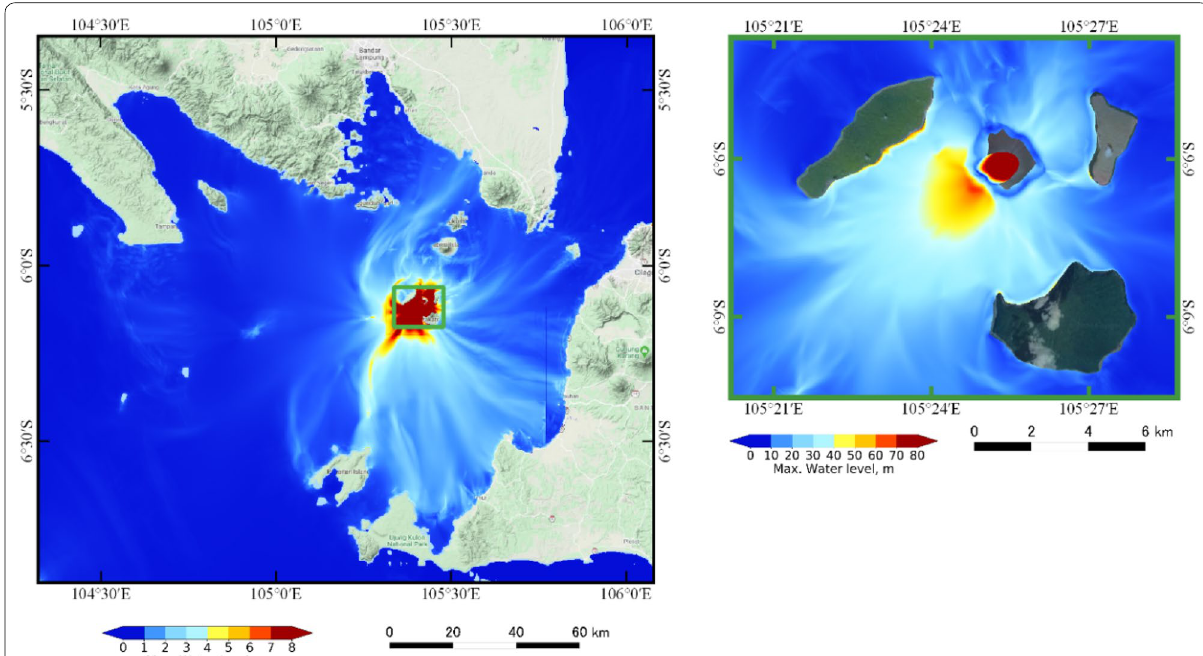
Fig. 9 Maximum wave height in the whole Sunda Strait area based on the optimum parameters obtained from the optimization